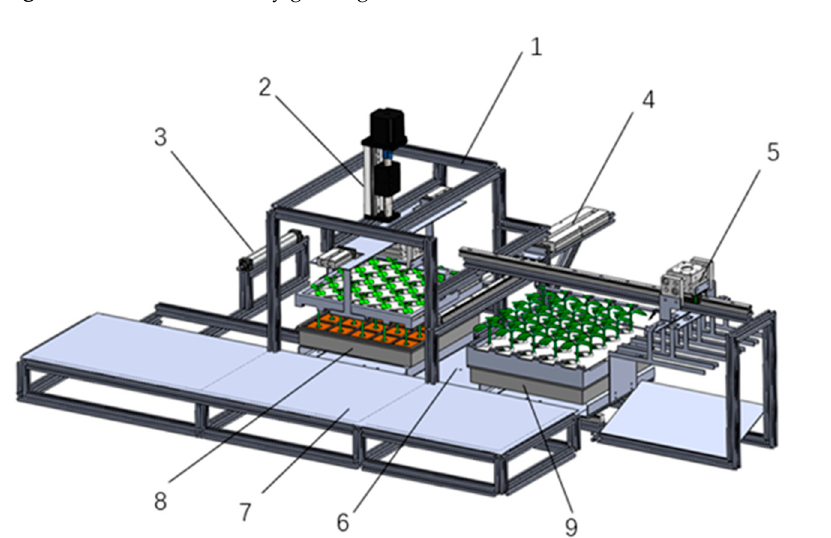
Figure 8. Process of full-tray grafting.